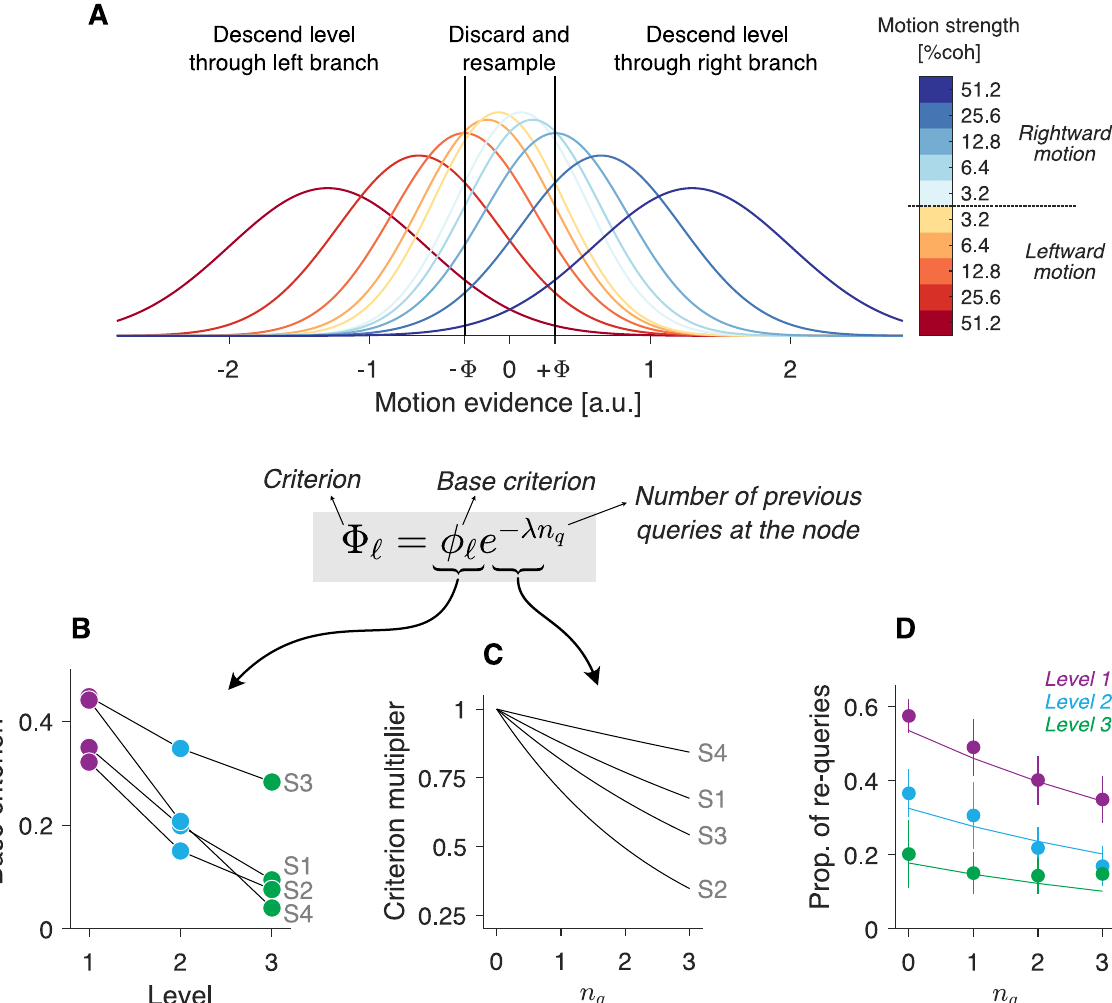
Fig 4. A simple detection model explains the motion choices. (A) Distributions from which the momentary motion evidence were sampled. The momentary motion evidence is normally distributed, with mean and variance that scale linearly with motion strength. The sign of the mean depends on motion direction. The slopes were fit independently for each participant (here we show the distributions from participant 1). The decision is made comparing an evidence sample against two criteria located at ± F . The criterion is given by the product of a base criterion, ϕ ℓ , and a term that decays exponentially with the number of successive queries made at the node ( n q ). (B) Base criterion for every participant and level of the decision tree, obtained from the best-fitting model. (C) The criterion, F , approaches zero exponentially as the number of successive queries at a node ( n q ) increases. Decay rate is determined by λ . Each curve depicts the best-fitting exponential function for each participant. (D) Frequency of re-queries, as a function of the number of previous successive queries at the node ( n ). This proportion decreases q with n q and with the level of the decision in the tree (indicated by the different colors). Solid lines are predictions from the detection model. Only the lower motion strengths (below 25.6%) were included in this analysis. Error bars indicate s.e.m. across